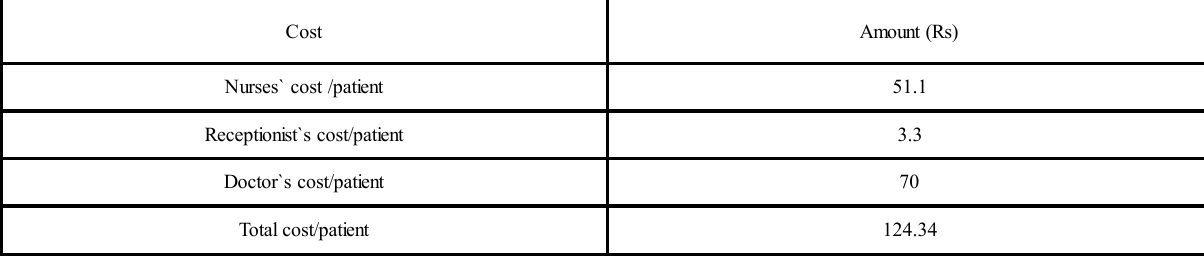
FIG. 12. PERCENTAGE OF SERVED PATIENTS WHEN THE DOCTORS‘ OPD TIME WOULD BE TABLE 11: AVERAGE SERVICE COST OF HOSPITAL SPENT ON EACH PATIENT